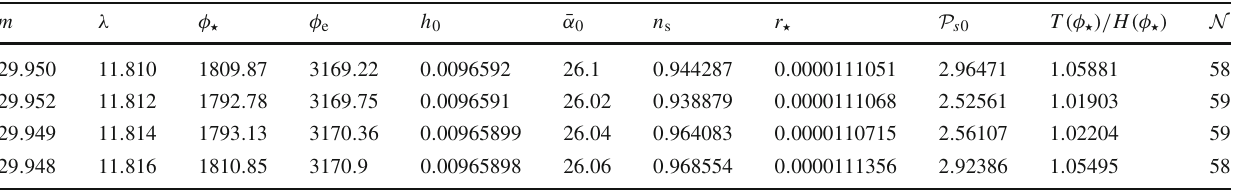
Table 1 Estimation of the free parameters of the non-comoving warm inflationary model in the weak dissipation regime with power-law scale factors by using the Planck 2013, 2015 and 2018 data sets, and for